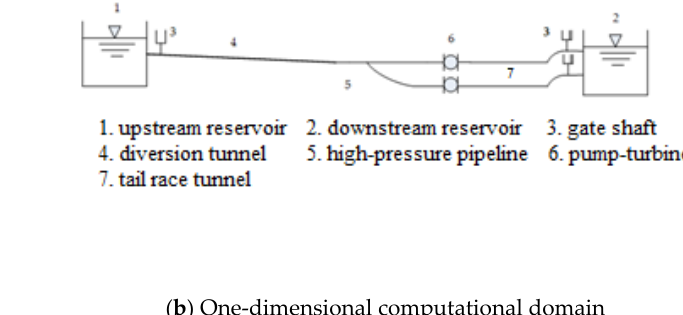
Figure 1. Computational model (3D and 1D).